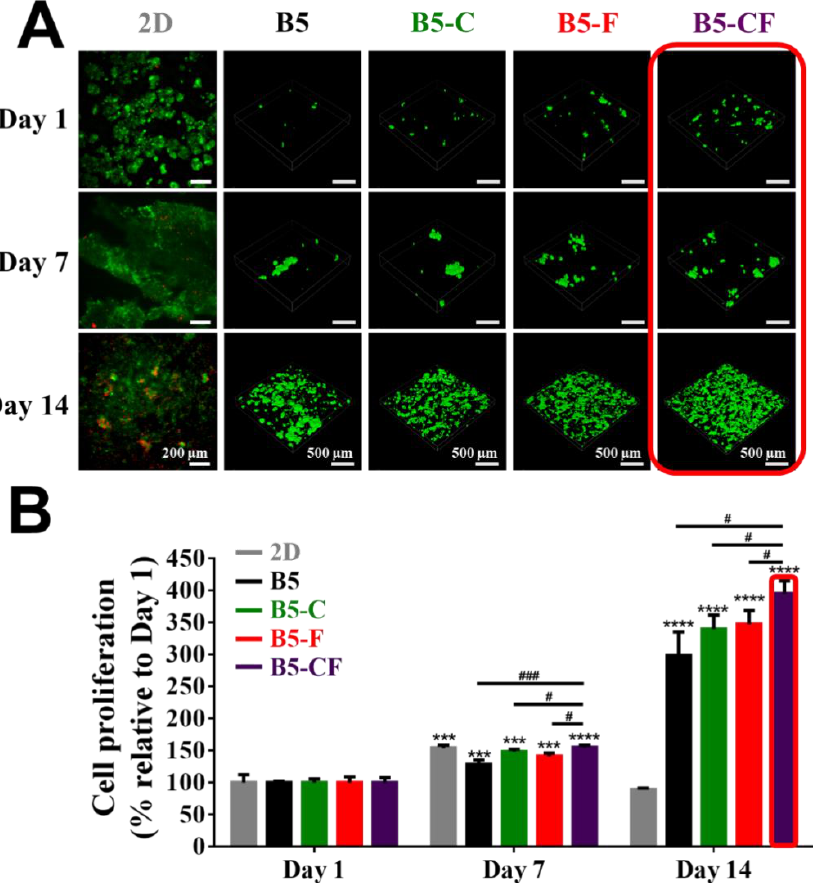
Figure 6. Cell proliferation of 2D, B5, B5-C, B5-F, and B5-CF samples for 14 days. ( A ) Cell viability was qualitatively assessed via the live/dead assay kit at day 1, day 7, and day 14. Live cells were stained green using calcein-AM, and dead cells were stained red using EthD-1. The 3D images of the inside of cell-laden BSAMA cryogels were taken with a confocal microscope with a 10 × lens. Scale bar: 200 µ m (2D); 500 µ m (3D). ( B ) Cell proliferation was quantitatively detected by CCK-8. n = 3, ***: p < 0.005, ****: p < 0.001, compared to the same cryogel type at day 1. #: p < 0.05, ###: p < 0.005, between two samples at the extremities of the line.